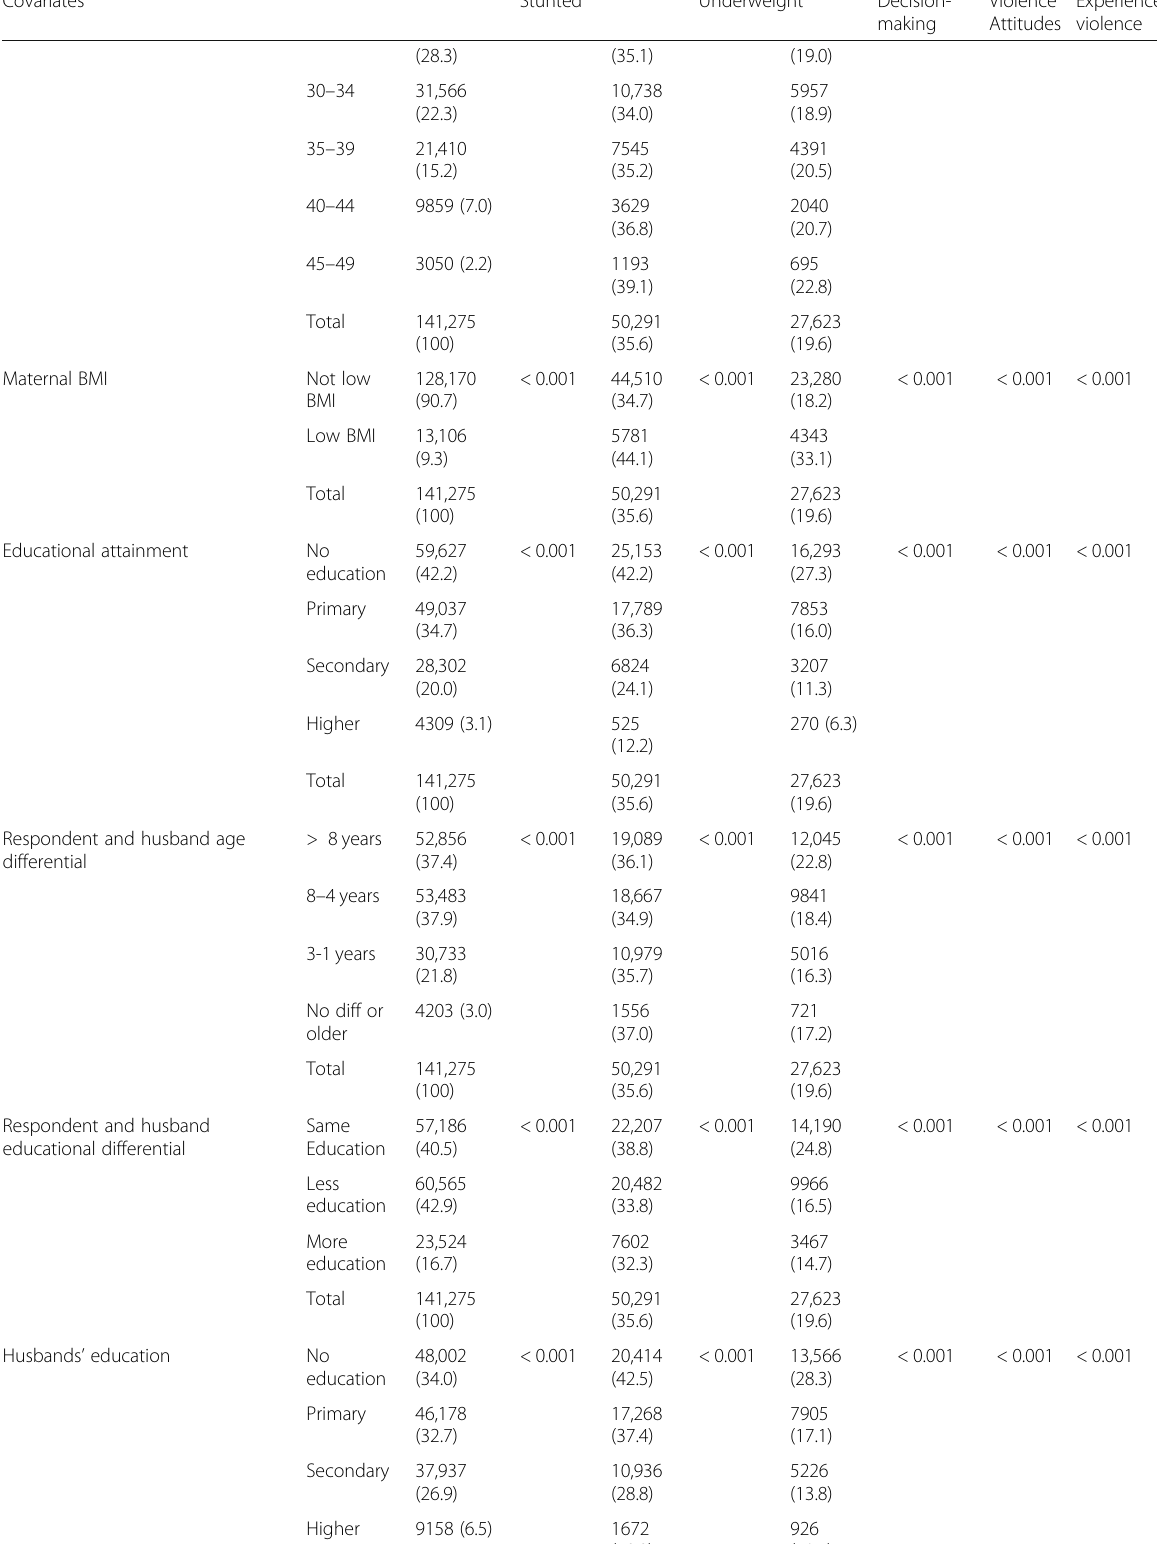
Table 3 Relationship between outcomes and Exposures with Covariates (Continued)